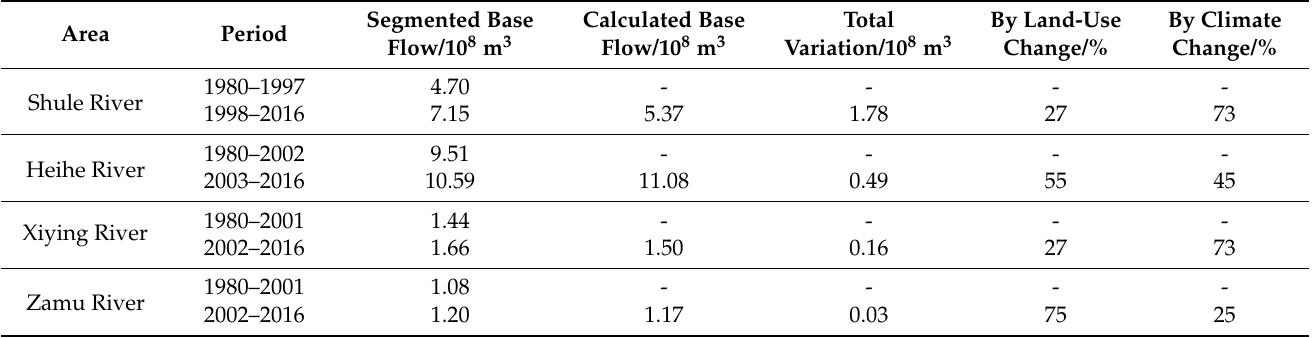
Table 8. Impacts of climate change and land-use change on the base flow in the Hexi inland rivers basin.